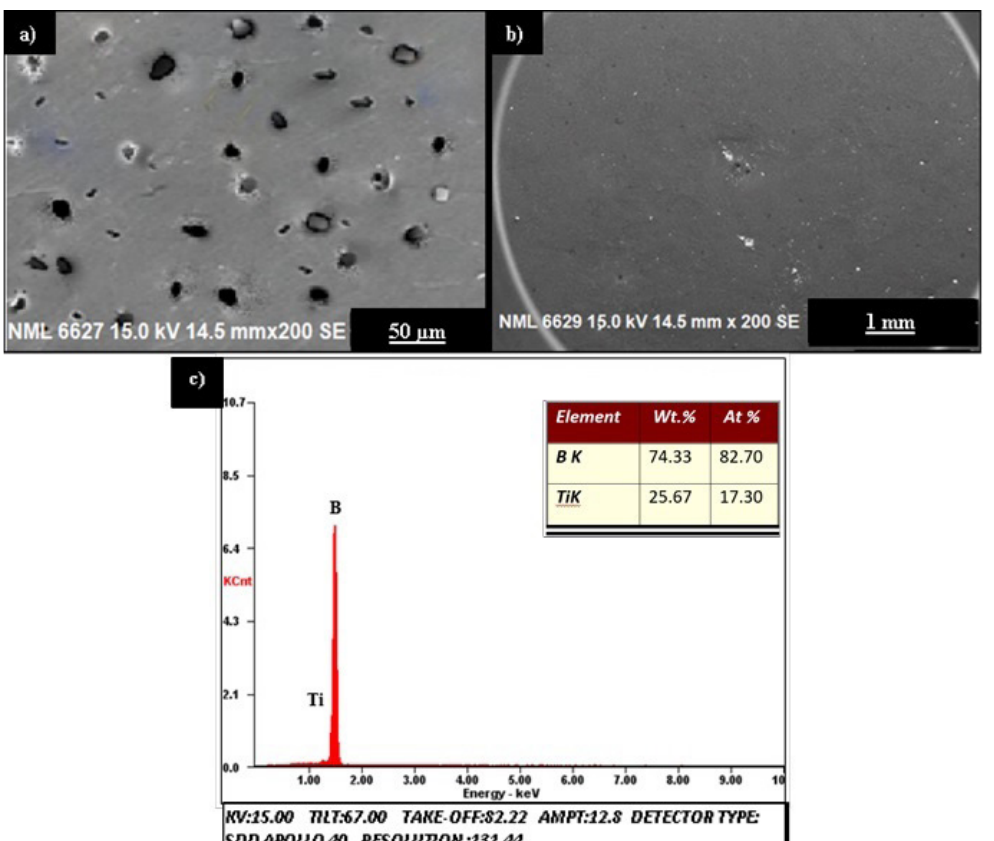
, (d) LM4 + 3 wt.% TiB 2